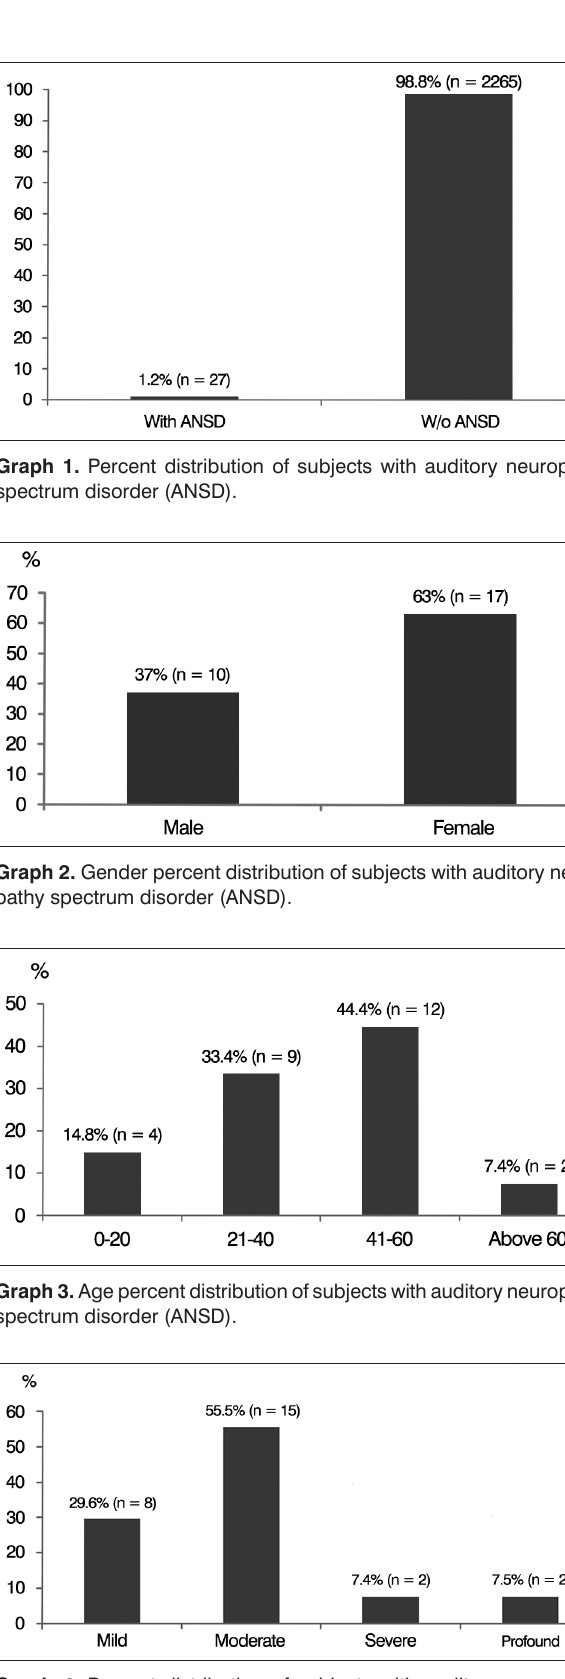
Graph 4. Percent distribution of subjects with auditory neuropathy spectrum disorder (ANSD) according to degree of hearing